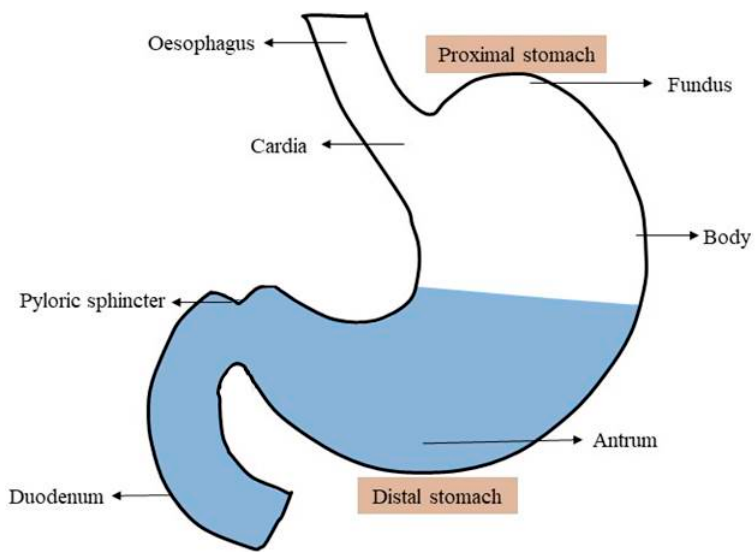
Figure 1. Schematic view on the anatomy of stomach.